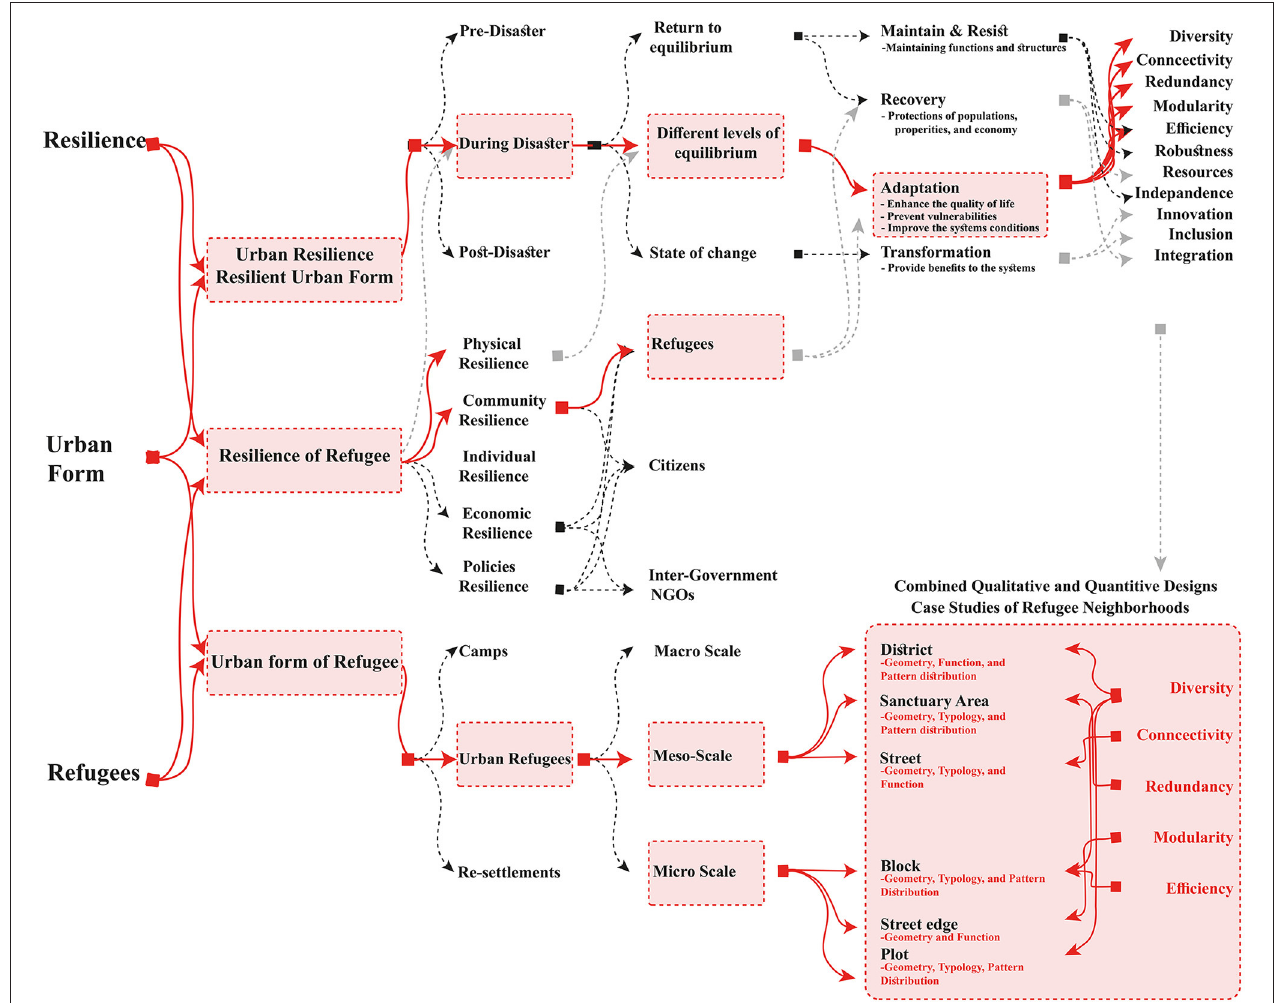
FIGURE 2 | The conceptual